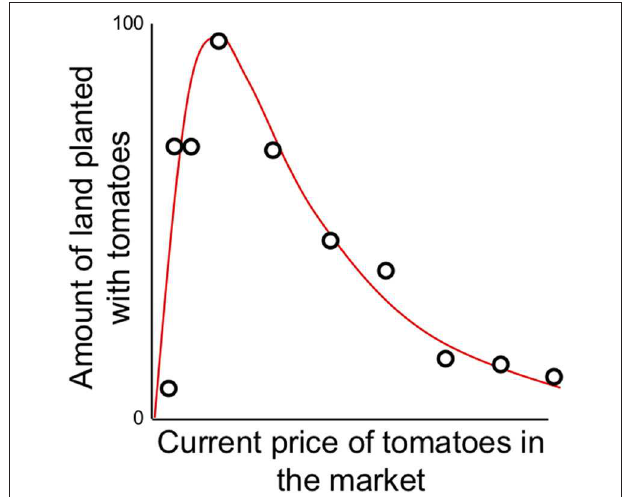
expected percentage of =